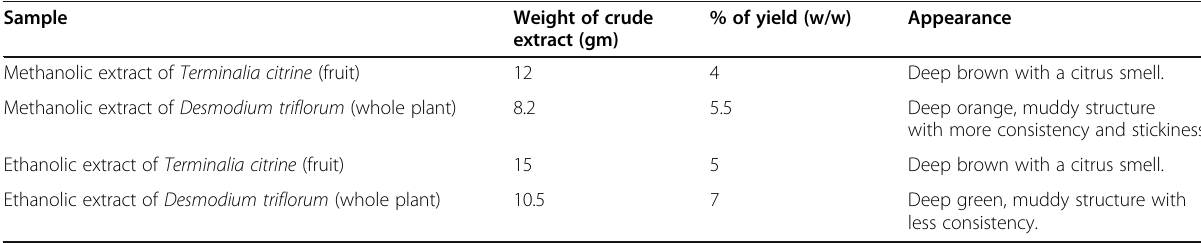
Table 1 The extractive values and physical appearances of different test extracts Sample Weight of crude